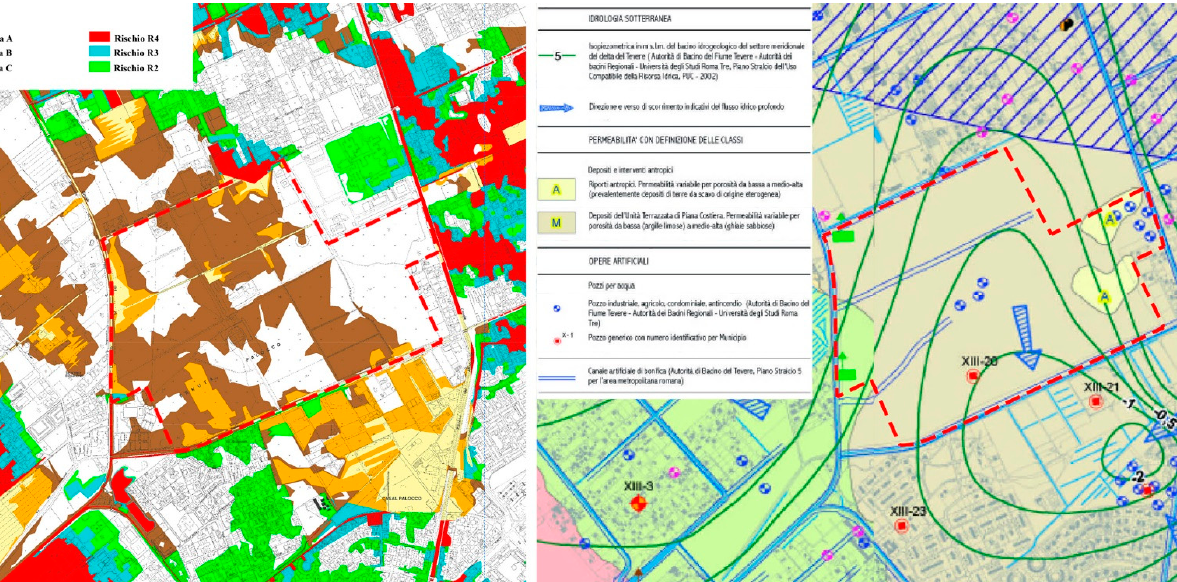
Figure 4. Analysis of the flow senses of the drainage channels of the Agro Romano. (Source: https://qgiscloud.com/CBLN/CBLN1. Accessed on 24 June 2022. Elaborations by the author). Project Data. The Equalization ‐ Offset Model and Ecological ‐ Environmental and Func ‐ tional Endowments The project data were obtained from the data sheets reported in the Appendix to the implementing technical standards of the General Regulatory Plan [65]. In keeping with